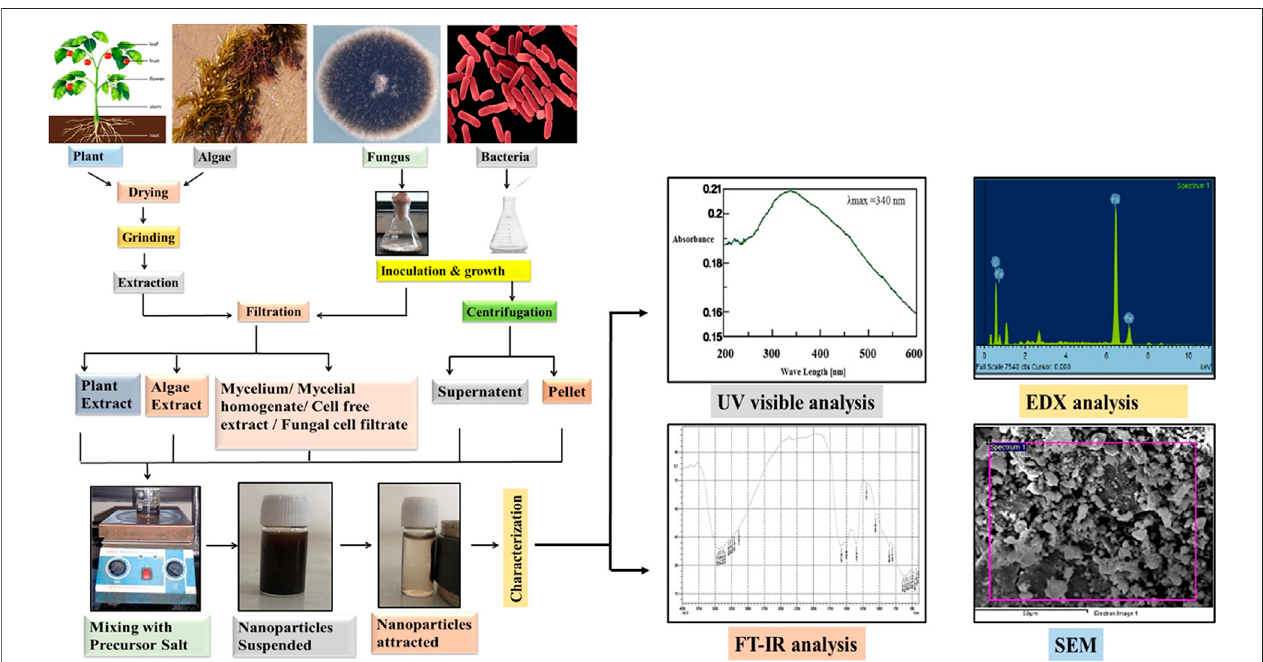
FIGURE 3 | General protocol for the biosynthesis of Iron oxide nanoparticles by using plants, algae, fungi and bacteria which includes drying, grinding and extraction of the biomaterial in the case of plants and algae whereas in case of bacteria and fungus initial steps include inoculation and growth. Extracted biomaterial is then fi ltered (plants, algae, fungus) and centrifuged (bacteria), followed by mixing with the precursor salt. At last the characterization of NPs is done by UV visible, FT-IR spectroscopy, EDX and SEM techniques.